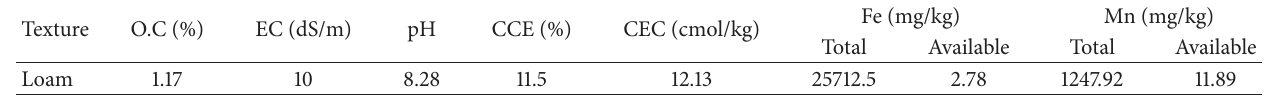
Table 1: Results of soil physical and chemical properties.